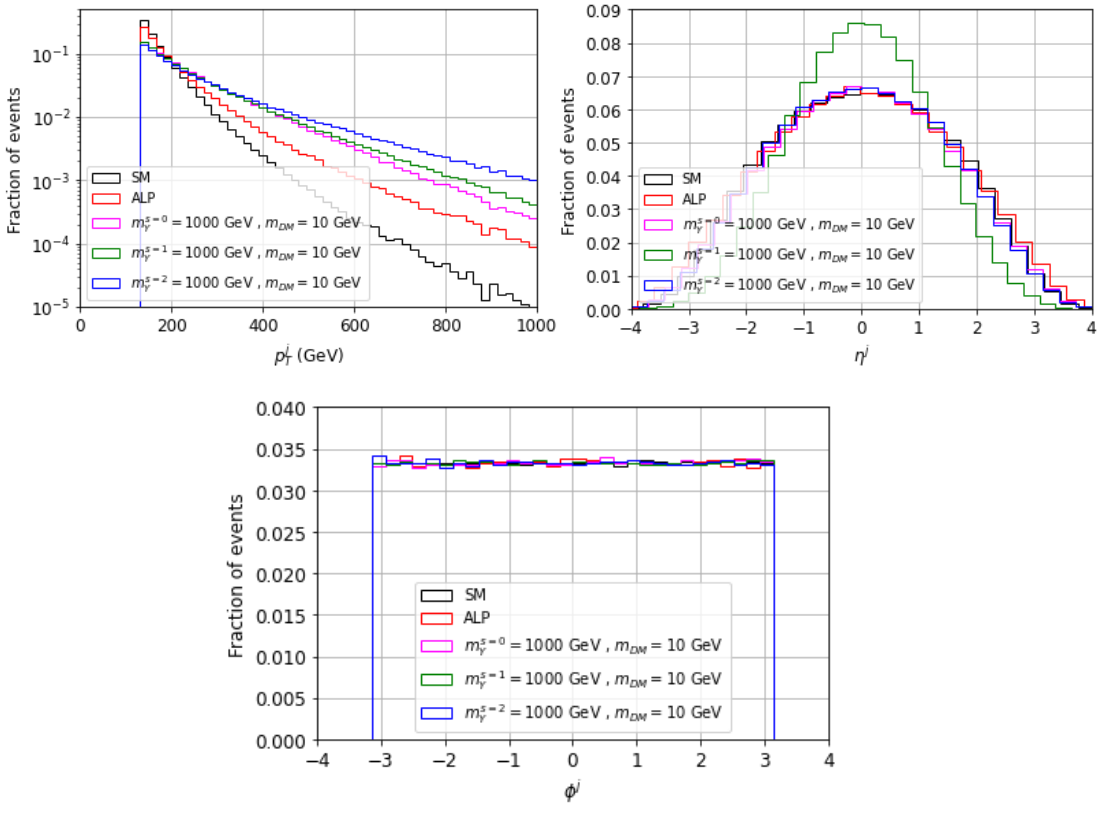
Figure 1: Kinematic distribution for the frameworks considered in this work at parton-level. For models with a mediator, these examples belong to the on-shell